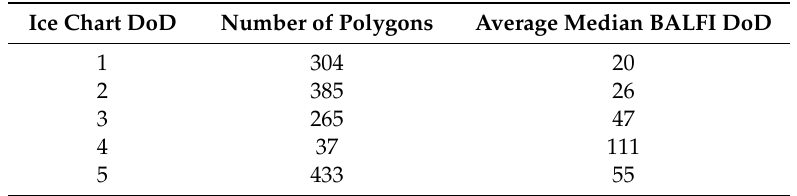
Table 2. Comparison between the degree of deformation (DoD) assigned manually to the ice chart polygons and the BALFI DoD. For each ice chart, polygon median BALFI DoD was calculated, and then their averages for each ice chart DoD class